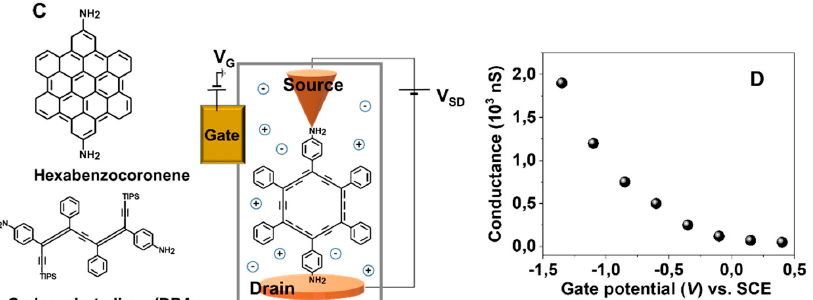
Figure 17. The scheme of devices built on an armchair graphyne nanoribbon (AGyNR) doped with boron and nitrogen atoms ( A ). The I-V curves of doped devices confronted with a pristine system; the inset figure shows the rectification ratio, RR (V), of all doped systems ( B ). Reproduced with permission [151]. Copyright 2018, Elsevier. The schemes of STM devices designed for the investigation SMC of carbobenzene, hexabenzocoronene, and carbo-n-butadiene (DBA). The molecules were attached via NH 2 linkers to gold STM electrodes; TIPS: triisopropylsilyl ( C ). The single molecule conductance (SMC) and gate potential (VG) relationship found for the carbo-benzene sample. In this experiment trihexyl tetradecyl-phosphonium-bis(2,4,4-trimethylphenyl)phosphinate) was applied as the electrochemical gating electrolyte and the bias voltage was constant (0.1V); SCE: saturated calomel electrode ( D ). Redrawn [153].